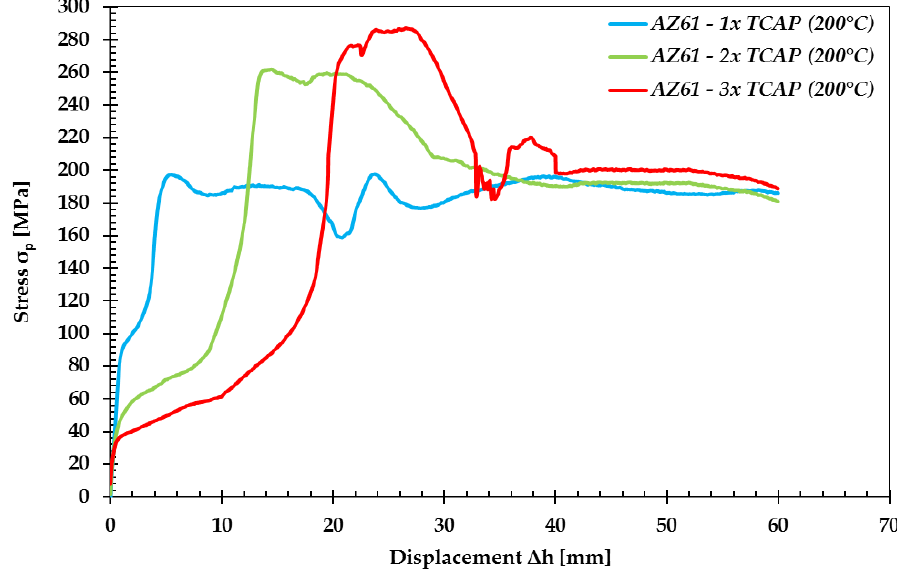
Figure 5. Stress-displacement curves of AZ61 after individual TCAP passes.